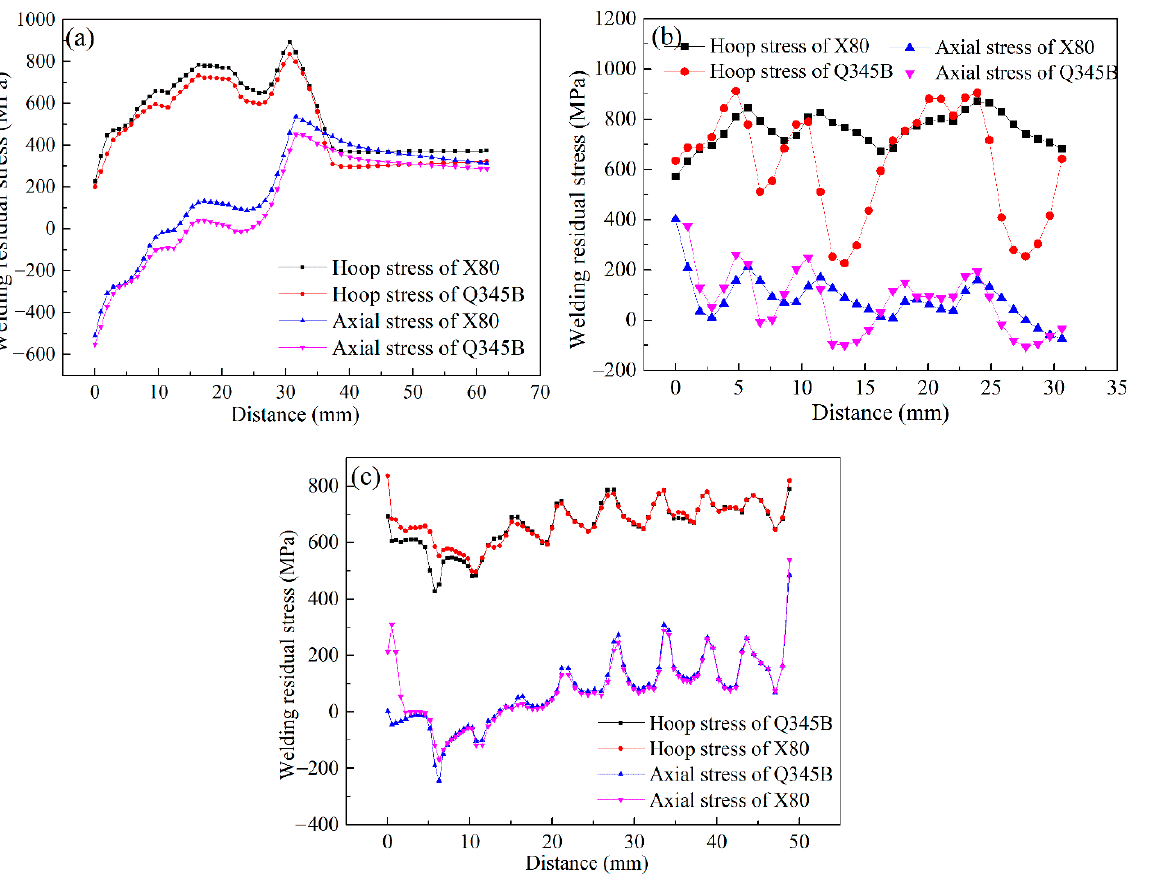
Figure 21. Residual stress distribution along ( a ) L1, ( b ) L2, ( c )